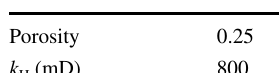
Table 1 Reservoir parameters